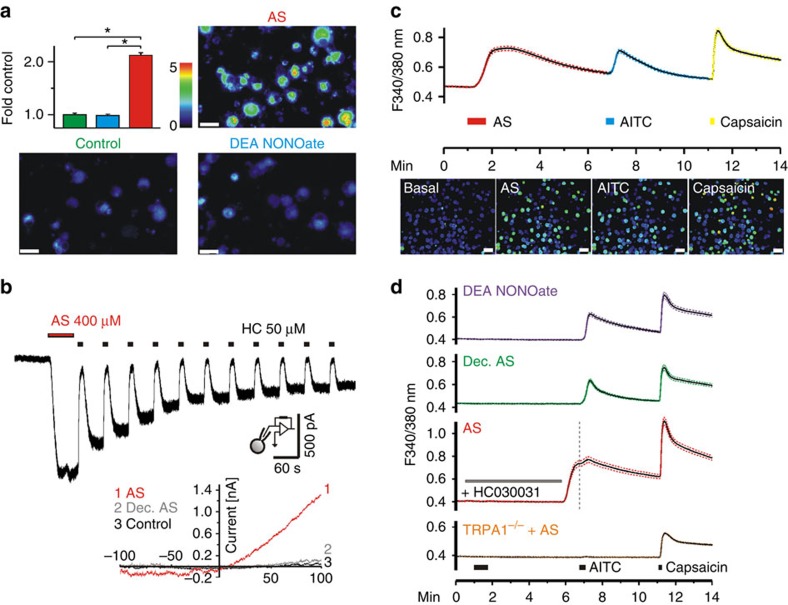
HNO released by AS activates TRPA1 channels.(a) Treatment with AS (300 μM) but not DEA NONOate (100 μM) increased fluorescence in sensory neurons (DRG) incubated with CuBOT1, a fluorescent dye for nitroxyl detection (analysis of variance following honestly significant difference post hoc test P<0.001; P=0.97, respectively; n=200 per group; scale bar, 40 μm). (b) AS (400 μM, 60 s) evoked inward currents in Chinese hamster ovary cells (n=7) expressing mTRPA1, which could be repeatedly blocked by HC030031 (50 μM, 10 s). Inset: Ramp currents through TRPA1 before (control, black) and during application of either decomposed AS (grey) or 400 μM AS (red). (c) Ca2+ influx (mean±s.e.m.) in DRG neurons of C57Bl/6 mice treated with AS (300 μM, 45 s), AITC (100 μM, 20 s) and capsaicin (0.3 μM, 10 s at 4-min intervals) and corresponding representative pseudocolor images (scale bar, 80 μm). (d) AS effects are abolished by application of HC030031 (50 μM) or decomposed AS and absent in TRPA1−/− mice. DEA NONOate (100 μM, 45 s) caused no effect. Data represent mean±s.e.m., n=300 DRG neurons for each group.